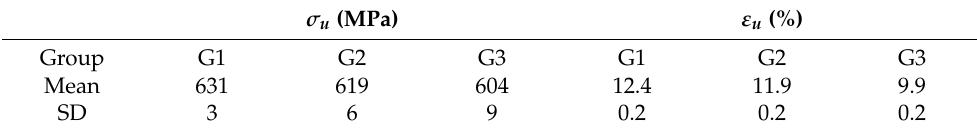
Table 3. Experimental ultimate stresses and strains (mean and standard deviation